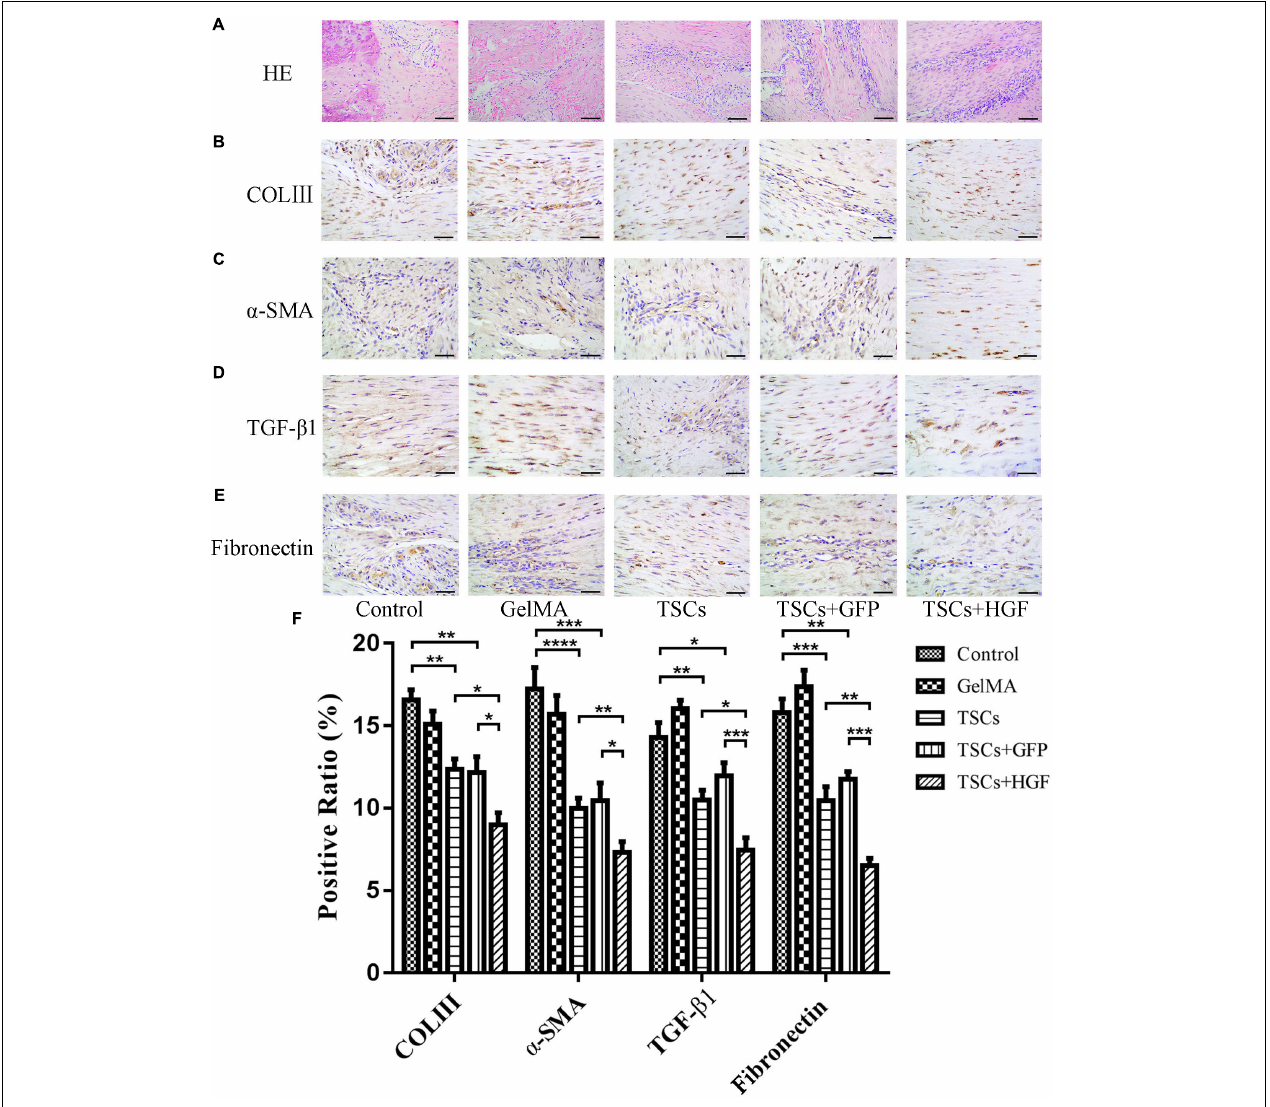
FIGURE 5 | Impact of treatment with TSCs expressing HGF (TSCs + HGF) on tendon levels of fibrosis-relevant proteins at 8 weeks postsurgery. (A) H&E stain of the tendon repair site. Immunohistochemical evaluation of (B) COLIII, (C) α -SMA, (D) TGF- β 1, and (E) fibronectin patterns. (F) Quantitation of fibrosis-relevant proteins ( n = 5). Bars: 50 µ m. Data are represented as mean ± SD. * P < 0.05, ** P < 0.01, *** P <